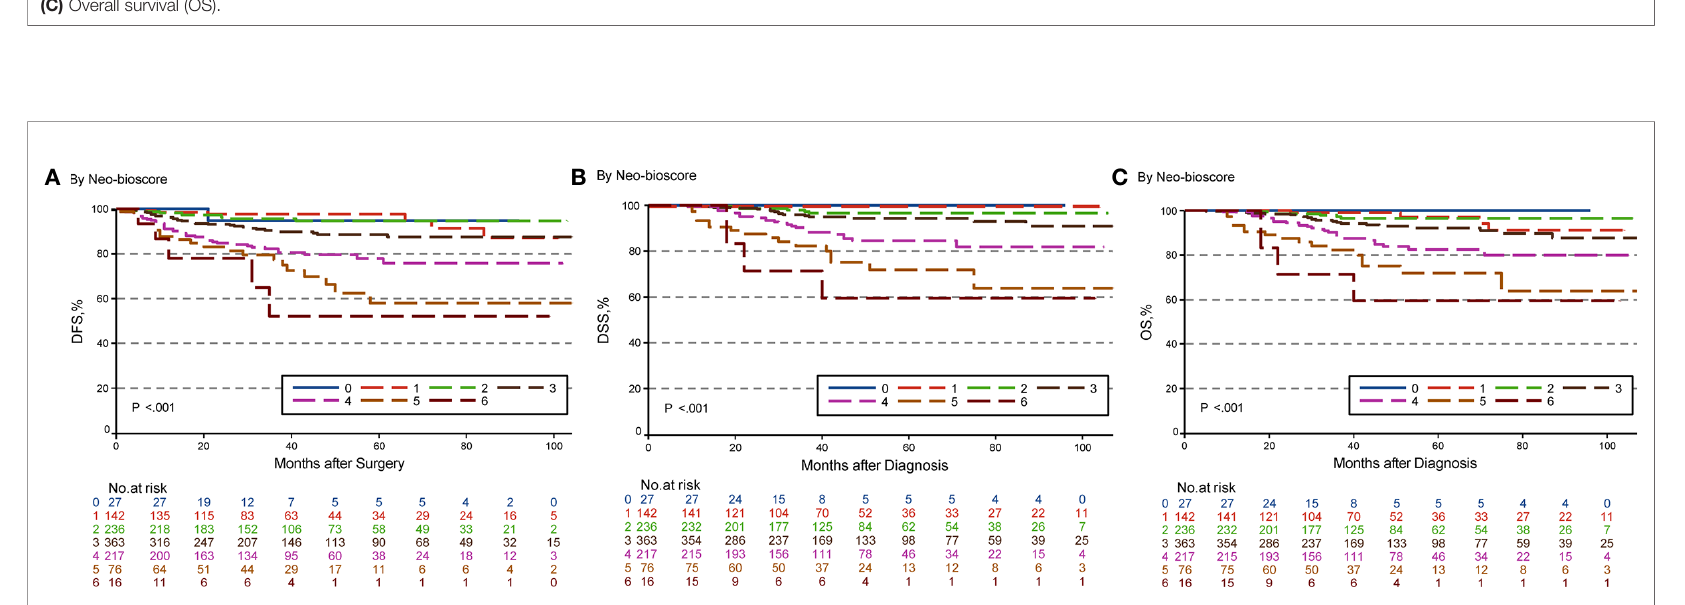
FIGURE 2 | Kaplan – Meier survival curves determined by CPS + EG in patients with breast cancer receiving preoperative systemic therapy (PST). (A) Disease free survival (DFS); (B) Disease speci fi c survival (DSS); (C) Overall survival (OS).